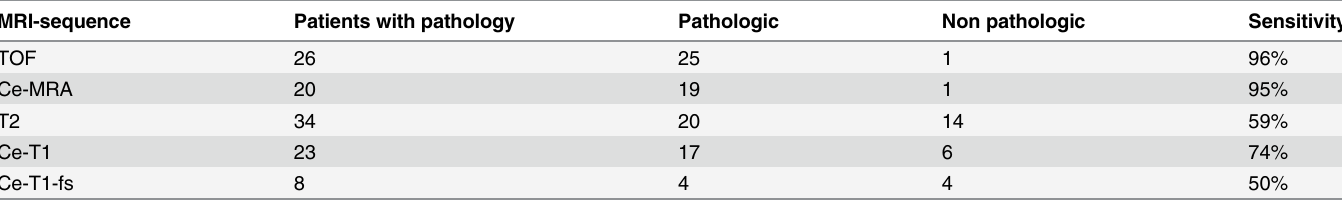
Table 2. Patient group with pathological correlate to PT with TOF-, ce-MRA-, T2-, ce-T1 and ce-T1-fs-sequences. MRI-sequence Patients with pathology Pathologic Non pathologic Sensitivity